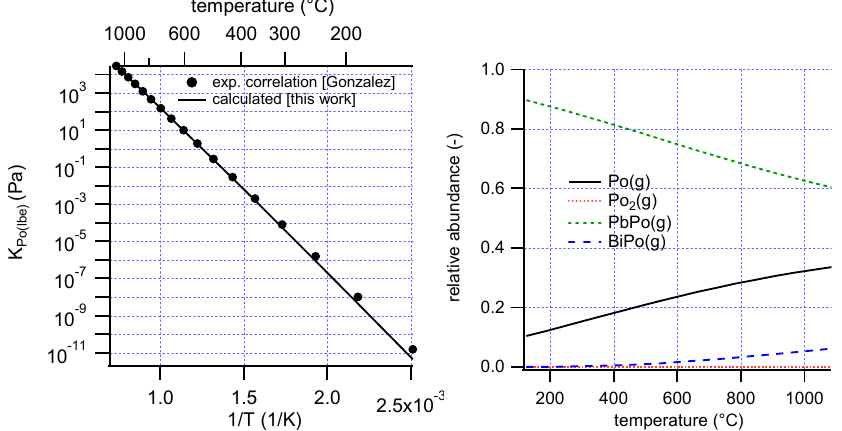
Figure 2. ( left ) Experimental correlation for the Henry constant of Po in LBE (markers) and calculated values (solid line). ( right ) relative abundance of Po vapor species in equilibrium with Po/LBE at x Po(lbe) = 4.6 × 10 − 8 .